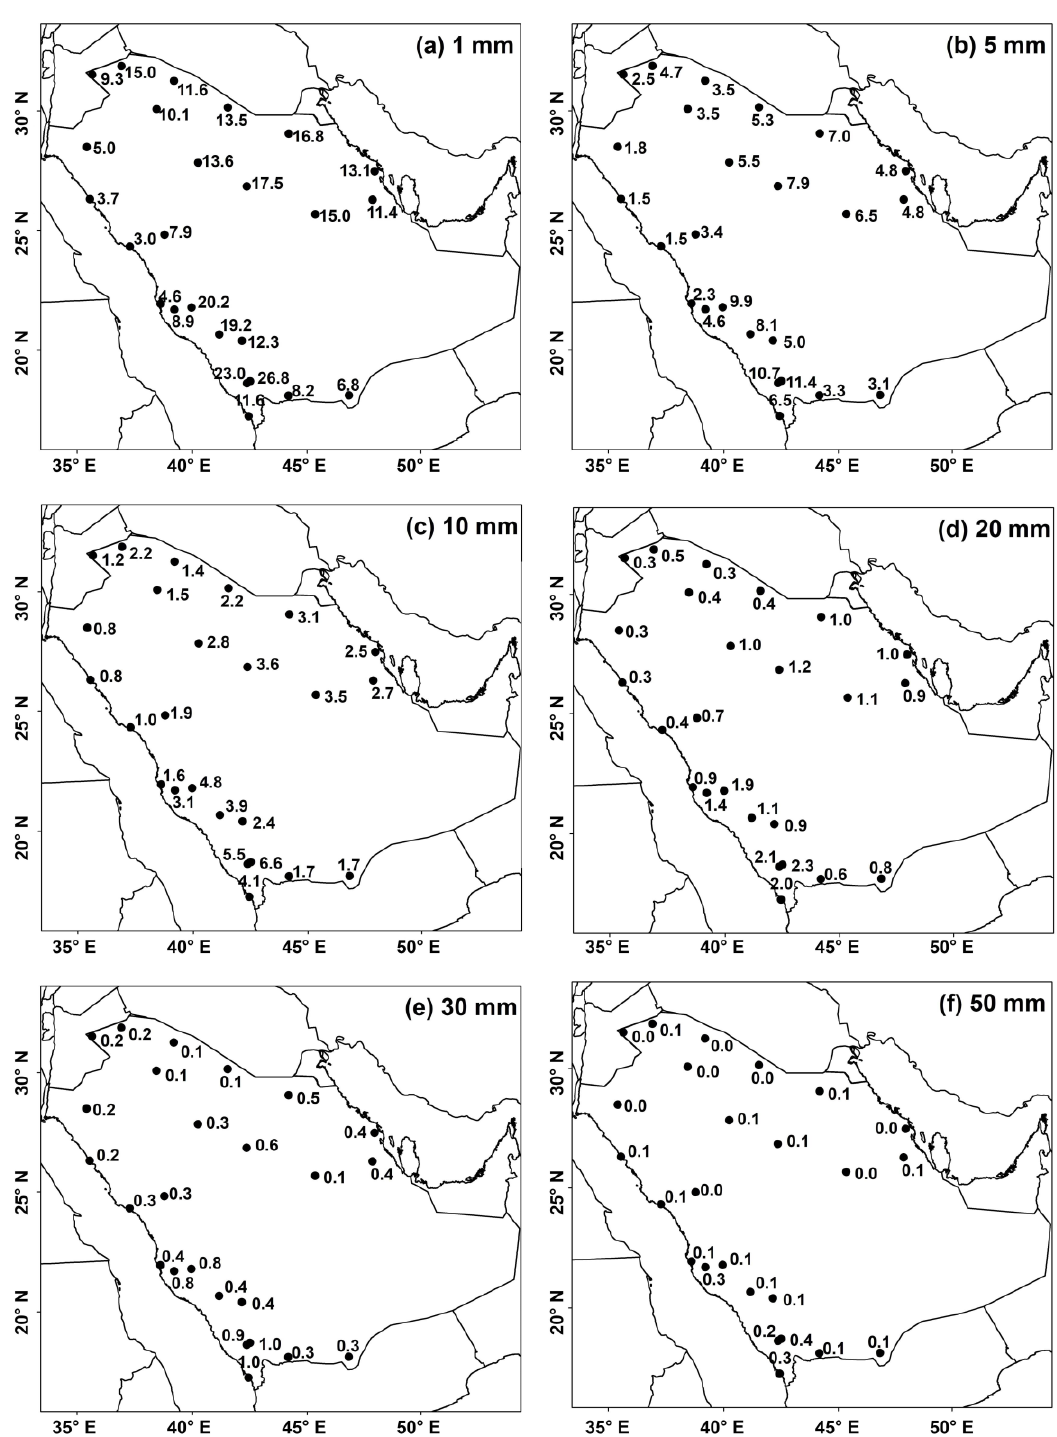
Figure 7. Annual frequency of rainfall extremes for thresholds: ( a ) 1, ( b ) 5, ( c ) 10, ( d ) 20, ( e ) 30, and ( f ) 50 mm for the period 1978–2019.